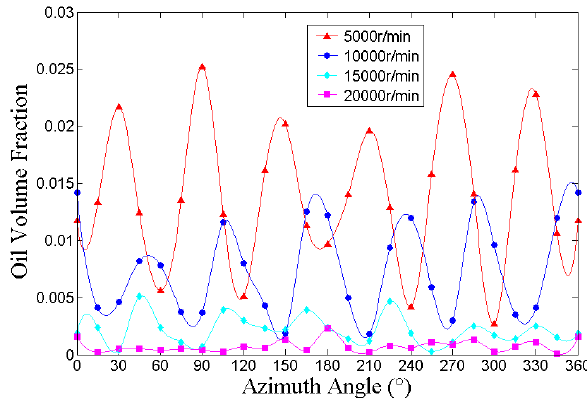
Figure 6. Oil volume fraction around the circumference with different rotational speeds.